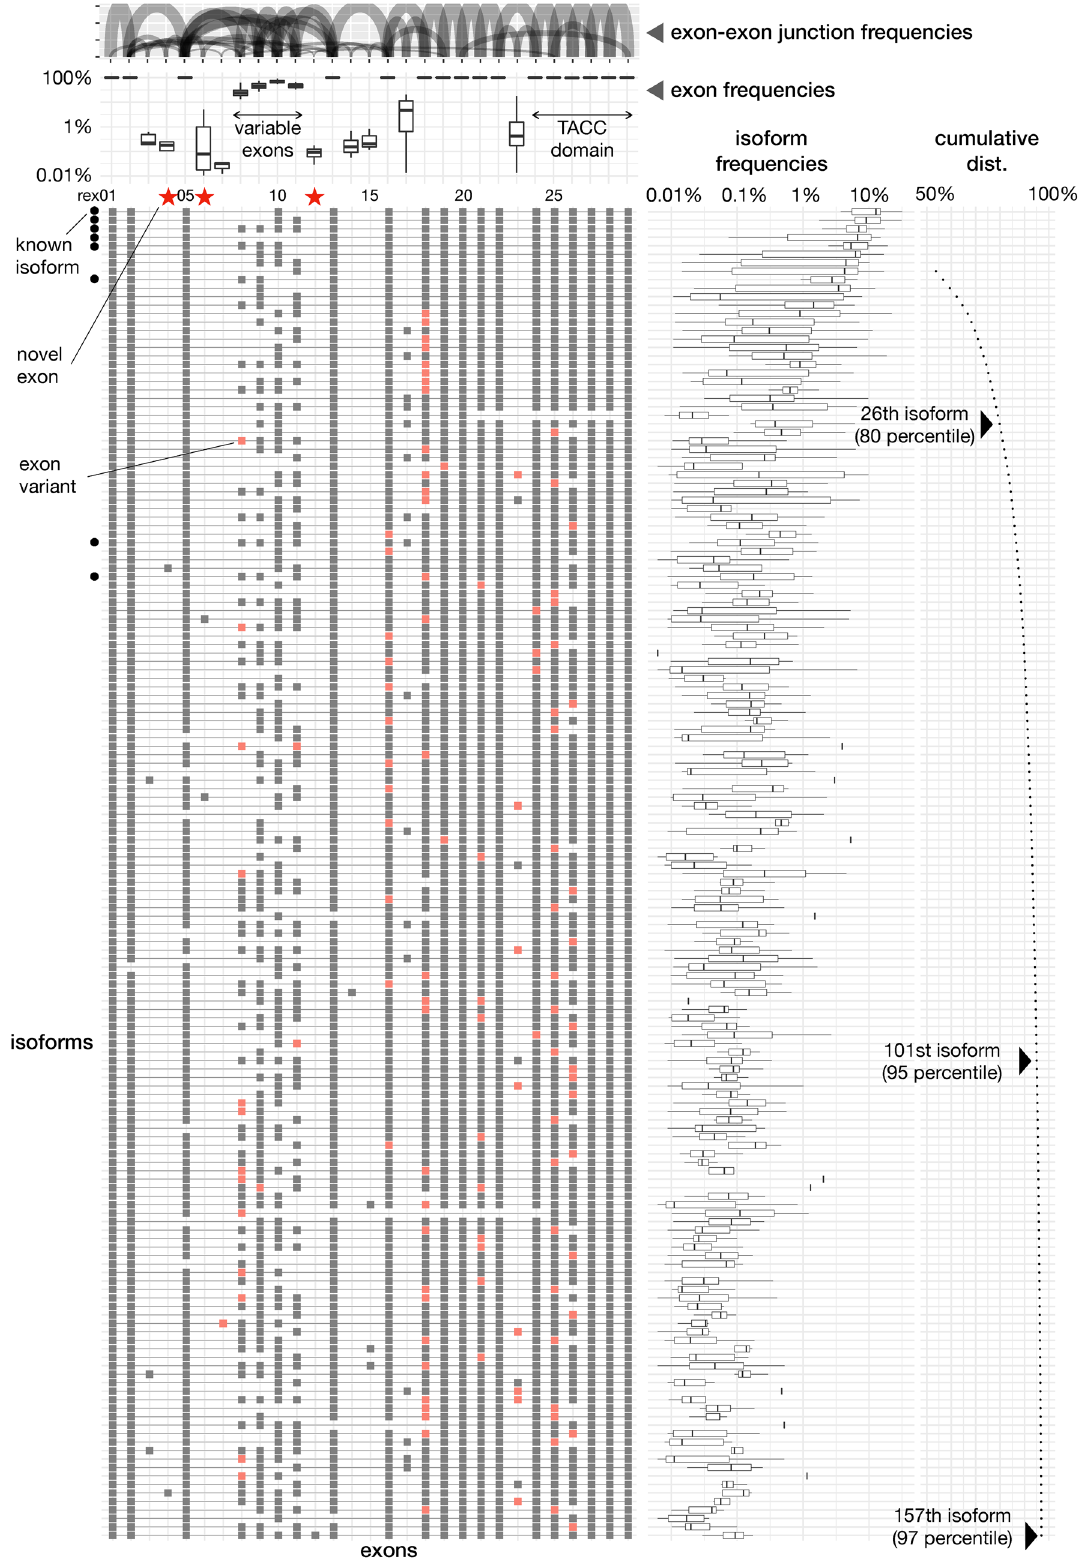
Figure 5. Isoforms transcribed from the TACC2 intronic promoter. Exon structures of 157 isoforms, where the validated novel exon rex12 firstly appears in 157th, are indicated by gray or pink boxes in the main (left bottom) panel. Isoform frequencies are shown by box plots in the middle panel, where frequency is calculated through dividing the number of corrected reads corresponding to the isoform by the total corrected reads per profile. The isoforms are ordered from the top by their total of corrected reads, the number of supporting evidences. Cumulative distribution is shown in the right